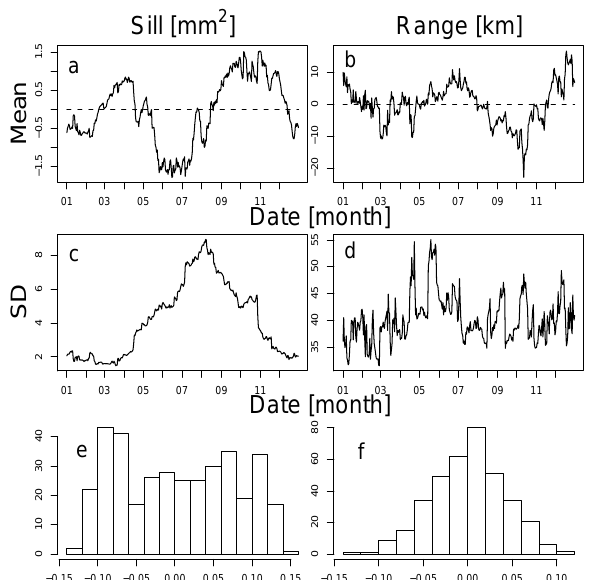
Fig. 9. Mean ( a and b ), standard deviation (SD; c and d ), and his- tograms ( e and f ) of the sill ( a , c , and e ) and range ( b , d , and f ). Mean and SD are shown as functions of the time of year.